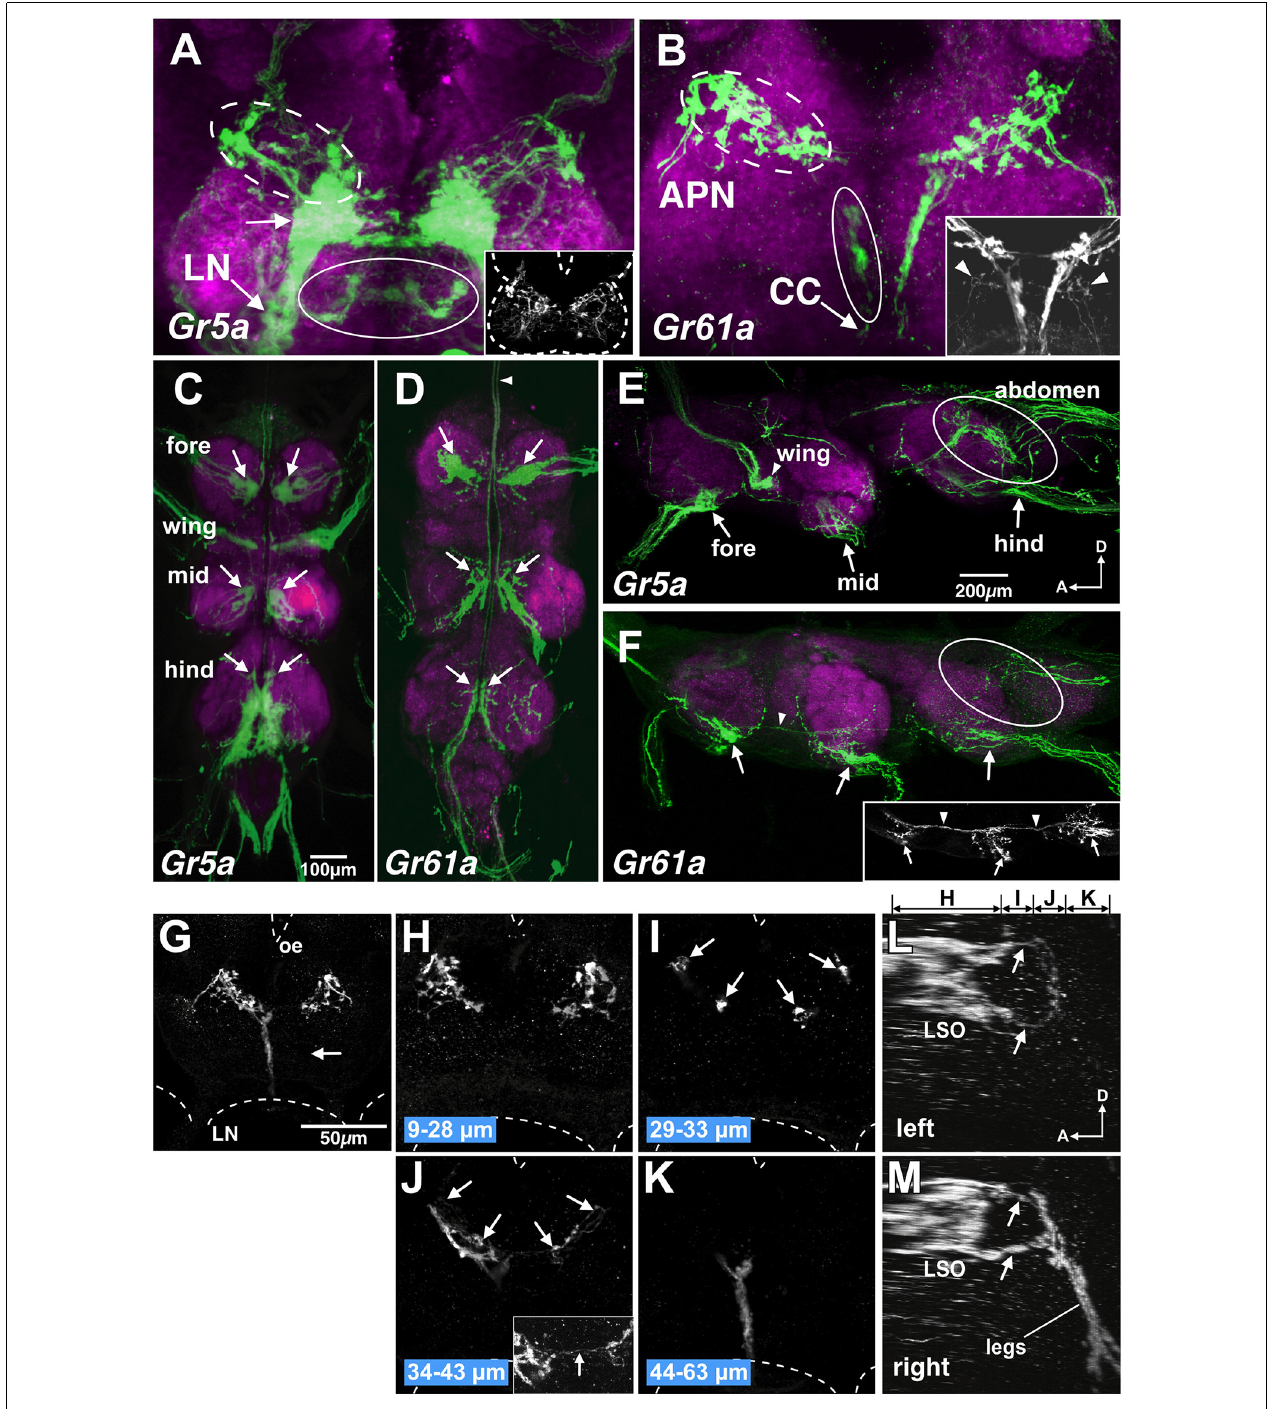
FIGURE 5 | Gr5a+ GRN axons project exclusively to thoracic neuromeres and subsets of Gr61a + GRNs project to the brain. (A,B) SOG doubly stained with anti-GFP (green) and nc82 monoclonal antibodies (magenta) from flies with genotypes of w ; Gr5a - Gal4 ; UAS-mCD8::GFP (A) and w ; Gr61a - Gal4 ; UAS-mCD8::GFP (B) . (A) A large stained cluster in the medial region (arrow) represents projections of axons of Gr5a + GRNs from labella. In addition, Gr5a+ afferents via the labial nerve (LN) are found in dorsolateral (dotted ellipse), ventral and posterior (ellipse) and anterior (inset) regions in the SOG. Dotted lines in the inset indicate the approximate outline of the brain. (B) Gr61a + GRNs entering the brain via the accessory pharyngeal nerve (APN) mainly project to the anterior SOG (dotted ellipse), and those entering via the cervical connective (CC) mainly project to the posterior (ellipse) SOG. (C–F) The ventral nerve cord (VNC) stained with the anti-GFP antibody (green) and the nc82 monoclonal antibody (magenta). The fly genotypes are: w ; Gr5a - Gal4 ; UAS-mCD8::GFP (C,E) and w ; Gr61a - Gal4 ; UAS-mCD8::GFP (D,F) .